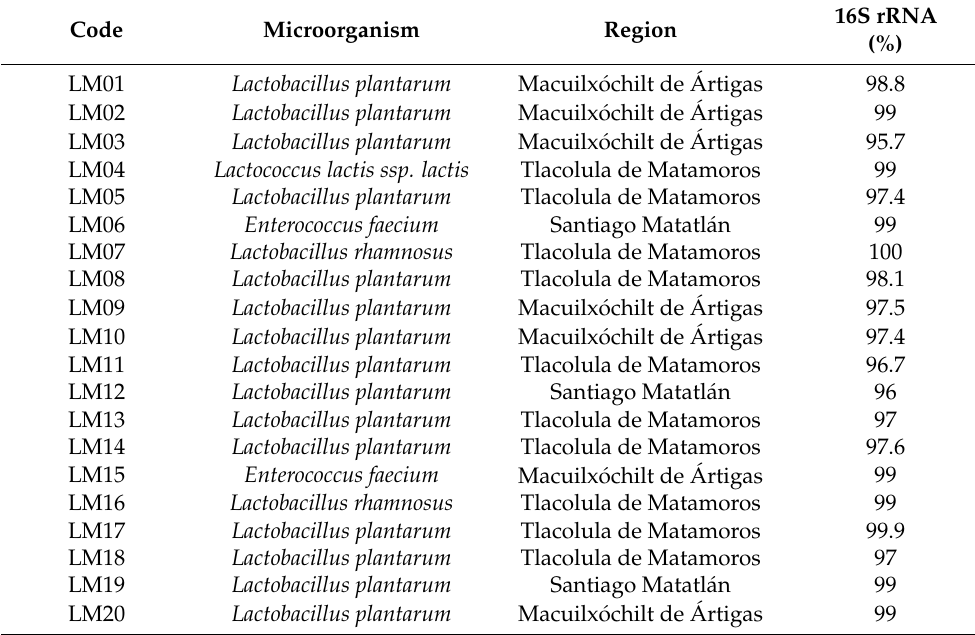
Table 1. List of lactic acid bacteria (LAB) isolated from agave-fermented samples from Macuilx ó chilt de Á rtigas, Tlacolula de Matamoros, and Santiago Matatl á n in Oaxaca, M é